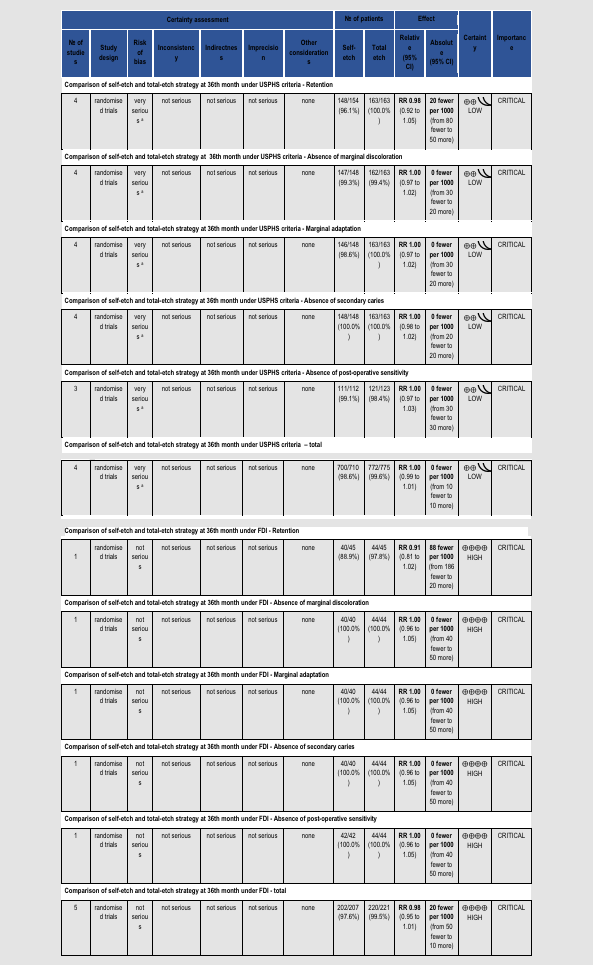
Table 6. GRADEpro assessment of certainty of evidence at 36 month follow-up using USPHS and FDI